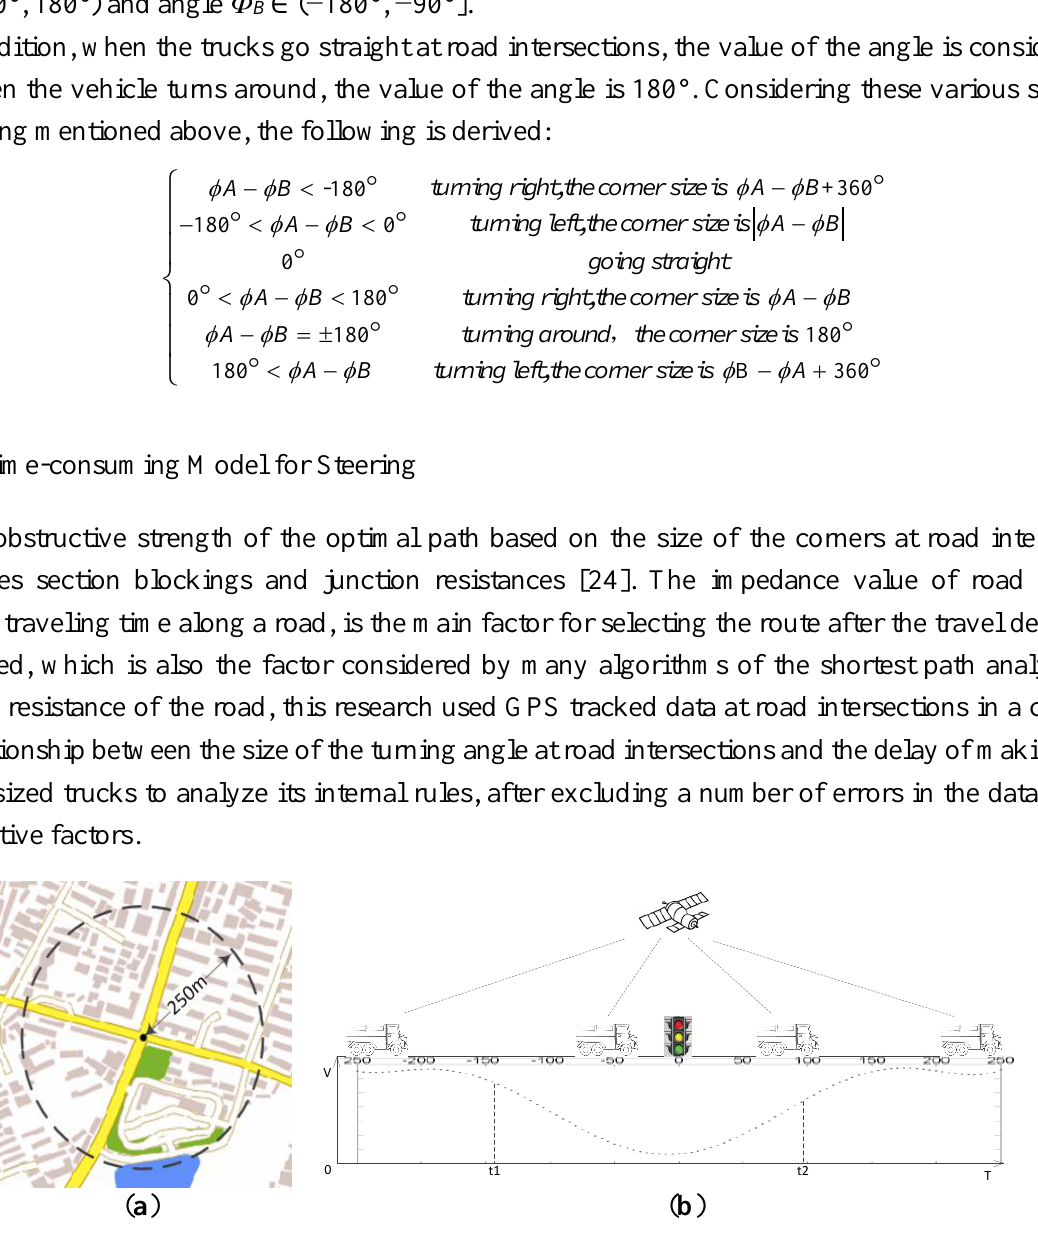
Figure 5. Calculation of the time consumed by making turns: ( a ) test area and ( b ) the definition of the time consumed by oversized trucks to make